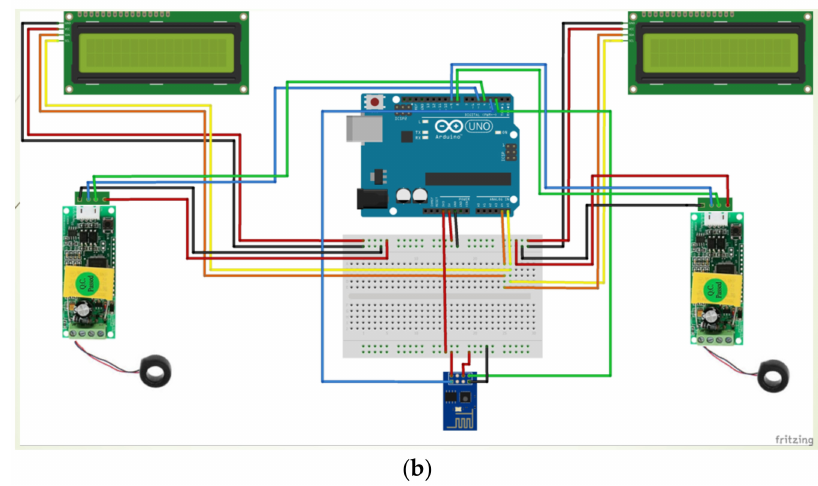
Figure 2. The simulation design of ISHDB in ( a ) Proteus and ( b ) Fritzing